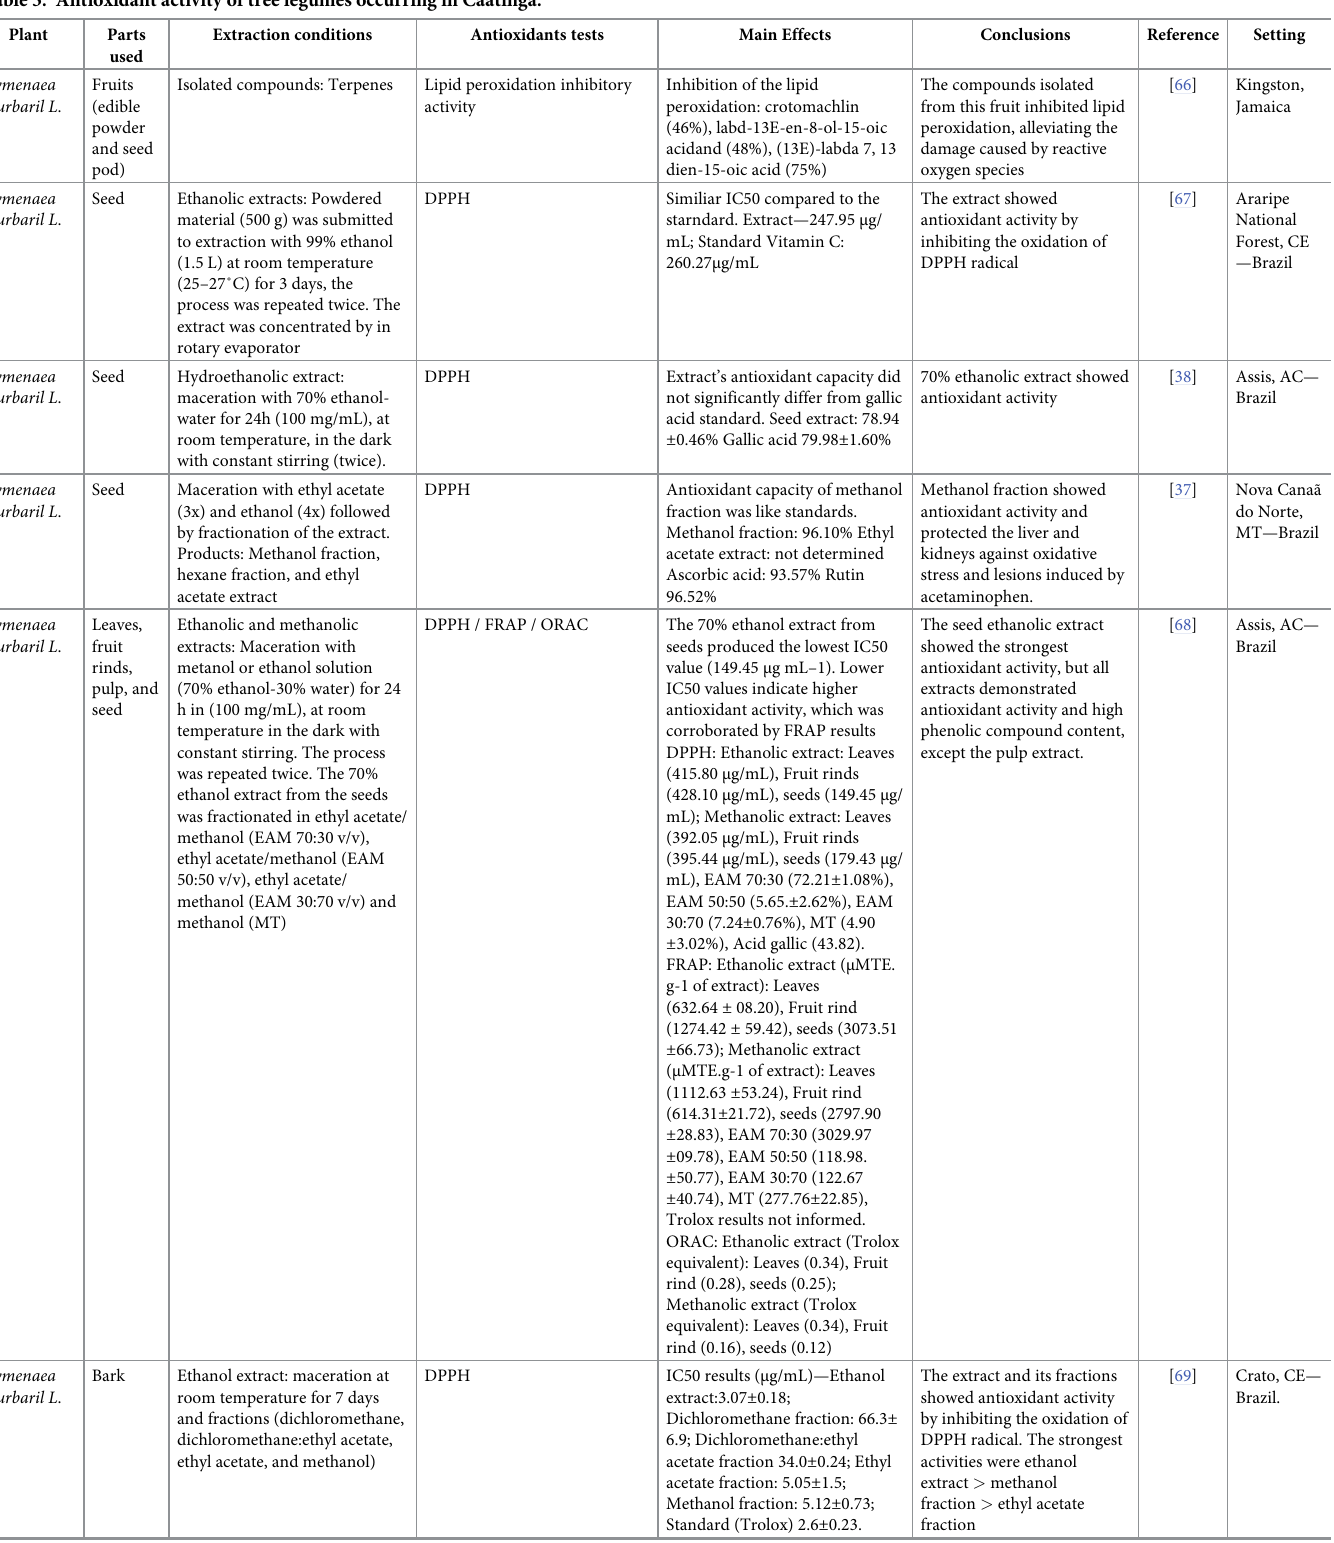
Table 3. Antioxidant activity of tree legumes occurring in Caatinga.